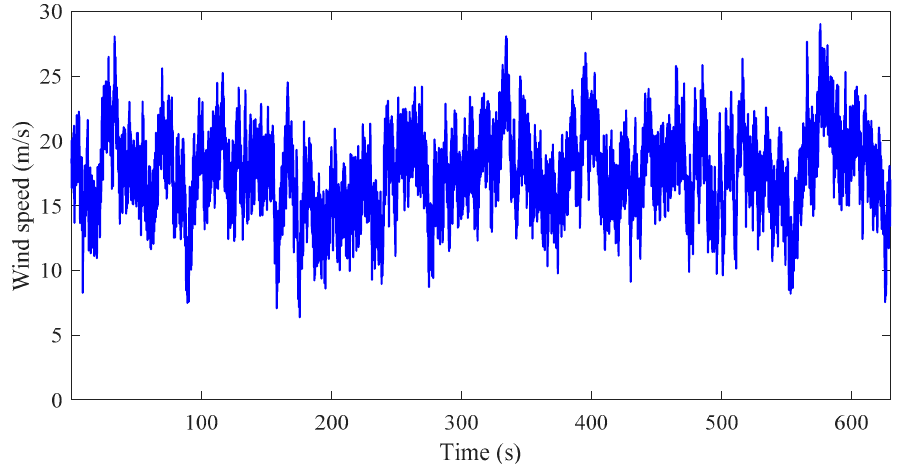
Figure 3. Wind speed sequence with mean speed of 17 m/s.